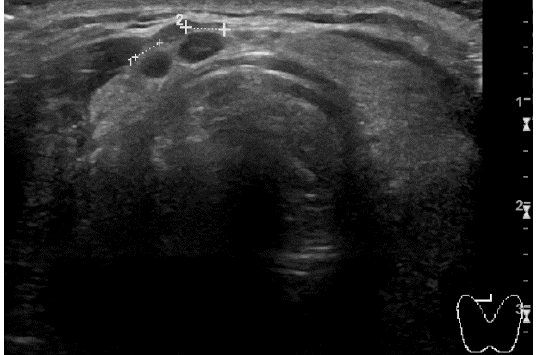
Figure 4. Immunotherapy ‐ related thyroiditis on neck US examination. The thyroid gland is enlarged and swollen; uneven tissue pattern and nodular areas of phlogistic infiltrate are visible.